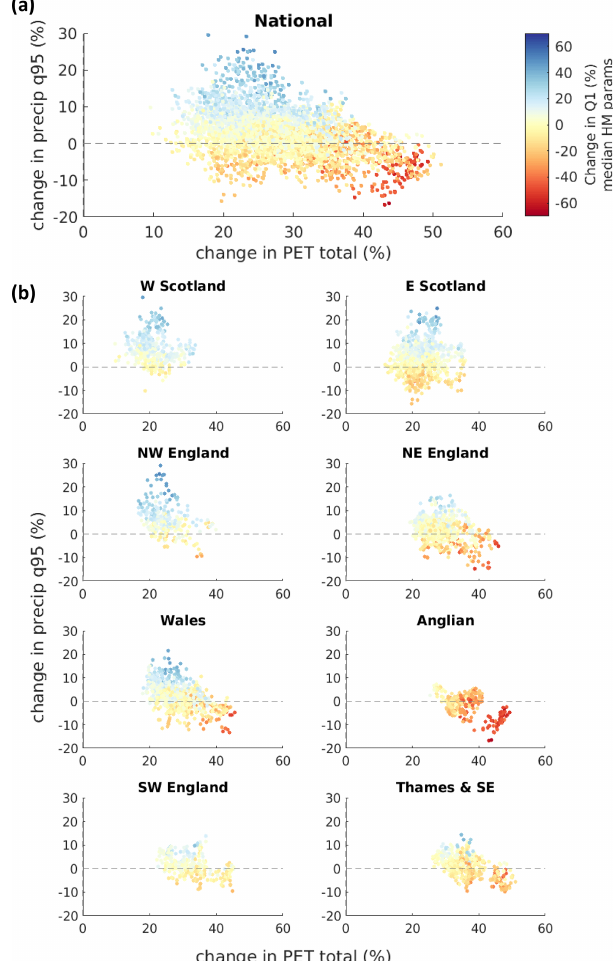
Figure 9. Relationship between changing climate and changing high flows (Q1), shown for all catchments nationally (a) and by re- gion (b) . Plots show climatic changes from all RCMs, coloured by the median change in Q1 flows from the ensemble of hydrological model parameter sets. Regions which are shown together exhibited similar